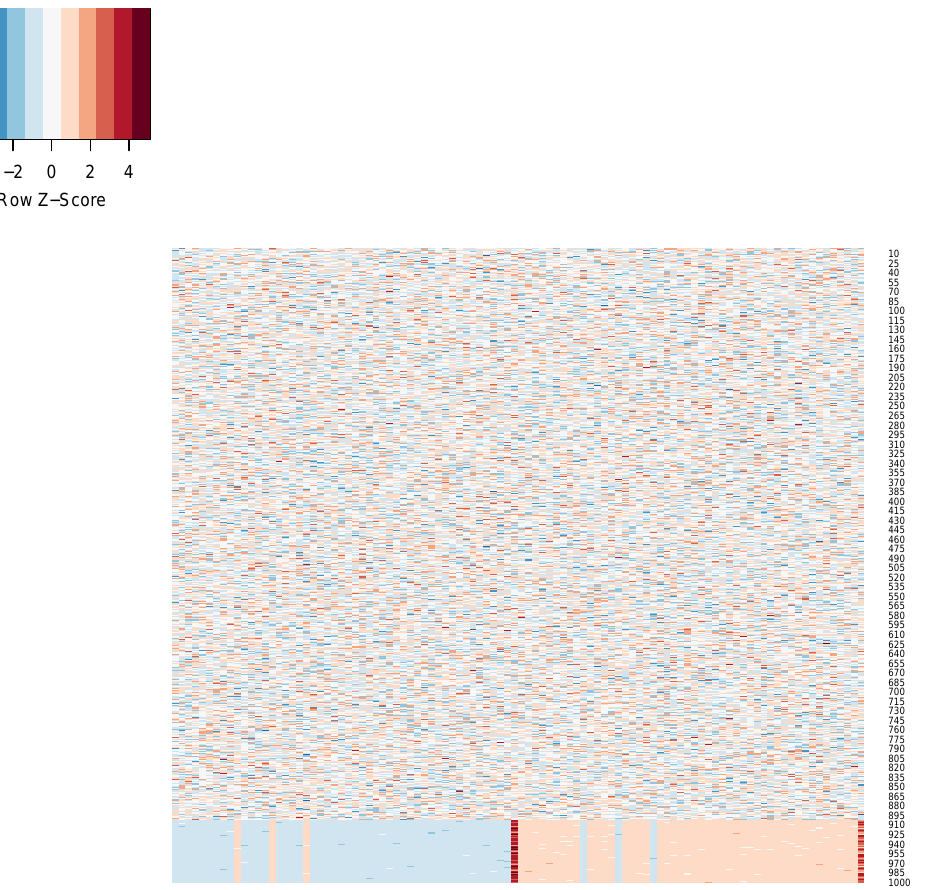
Figure 4. The heatmap of the first synthetic dataset, sizing 1000 × 100, in which rows and columns ideally correspond to genes and samples, respectively. The map evidences the changes of samples 10, 15, and 20 of class C 1 with samples 60, 65, and 70 of class C 2 and the different distribution of last sample of each class into the 100 last rows of the data matrix.